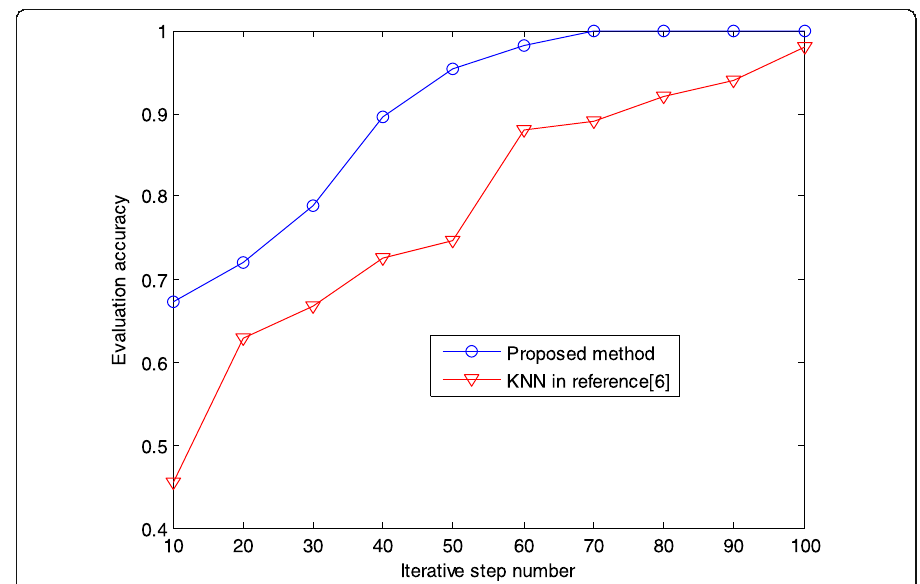
Fig. 5 Influence of anchor nodes in corner position on GIL location algorithm